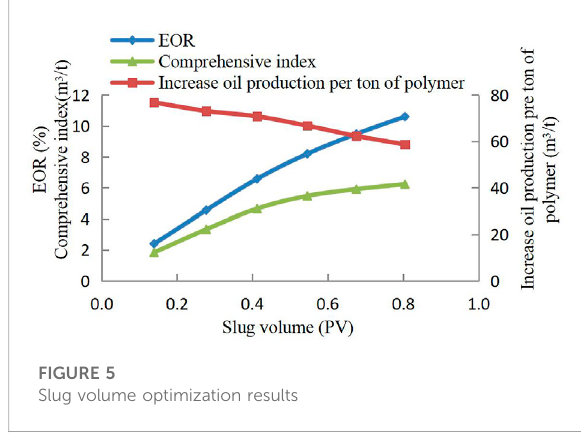
FIGURE 5 Slug volume optimization results